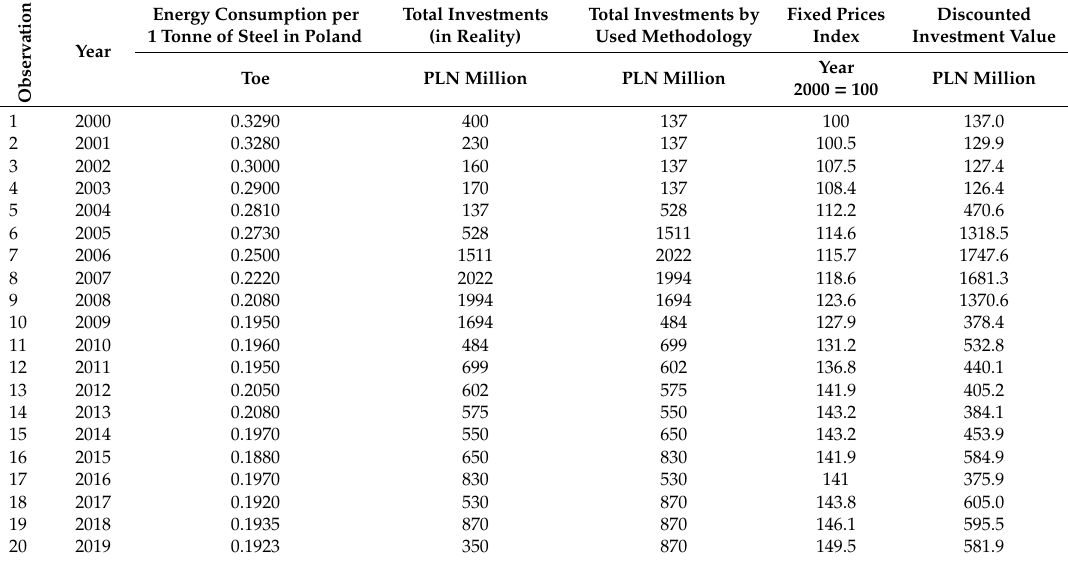
Table 1. Values of energy consumption per one tonne of steel production and the value of investment in new technologies in the years